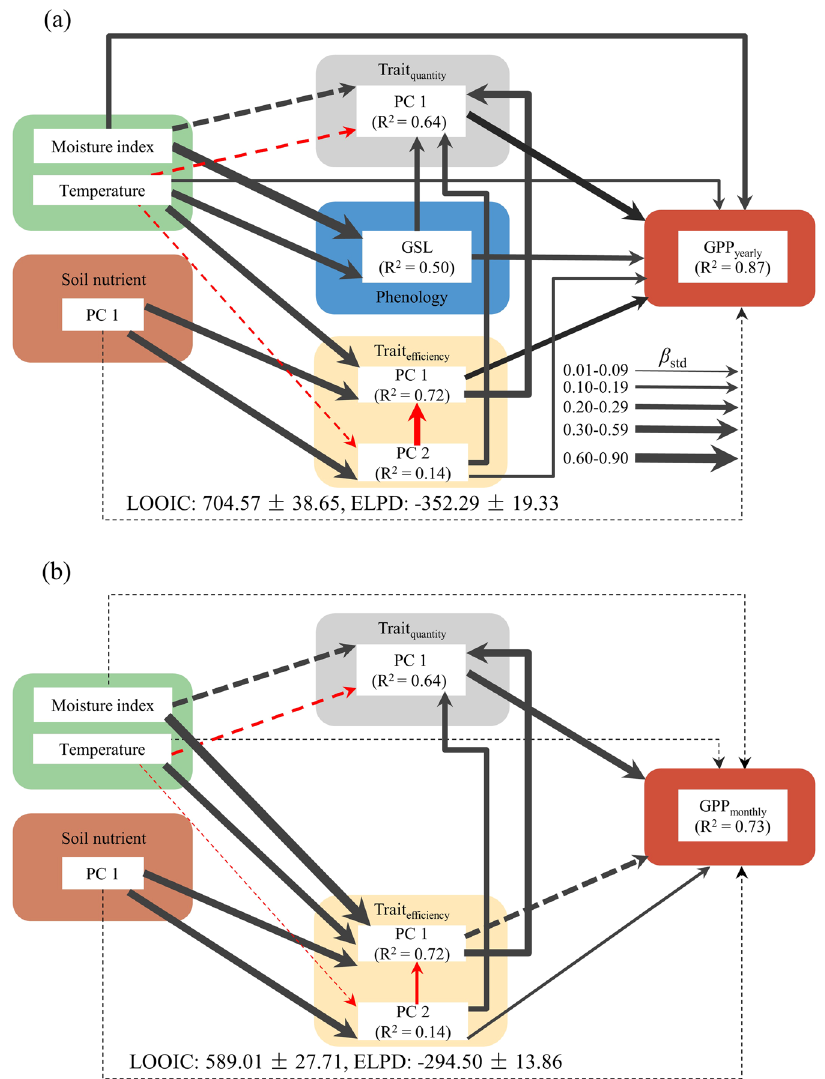
Fig. 3 Results from Bayesian piecewise structural equation models. Bayesian piecewise structural equation models exploring the direct and indirect effects of environmental factors and traits on gross primary productivity (GPP) across all sites: (a) yearly GPP (GPP yearly ) and (b) monthly GPP (GPP monthly ). PC 1 and PC 2: the fi rst two principal components (PCs) of the corresponding variables; Trait quantity and Trait ef fi ciency : quantity and ef fi ciency traits, respectively; GSL: length of the growing season (months); β std : standardized path coef fi cients; black and red arrows: positive and negative relationships, respectively; solid and dotted lines: signi fi cant and non-signi fi cant effects, respectively; arrow width is proportional to the strength of the relationship; LOOIC: leave-one-out cross-validation information criterion; ELPD, expected log predictive